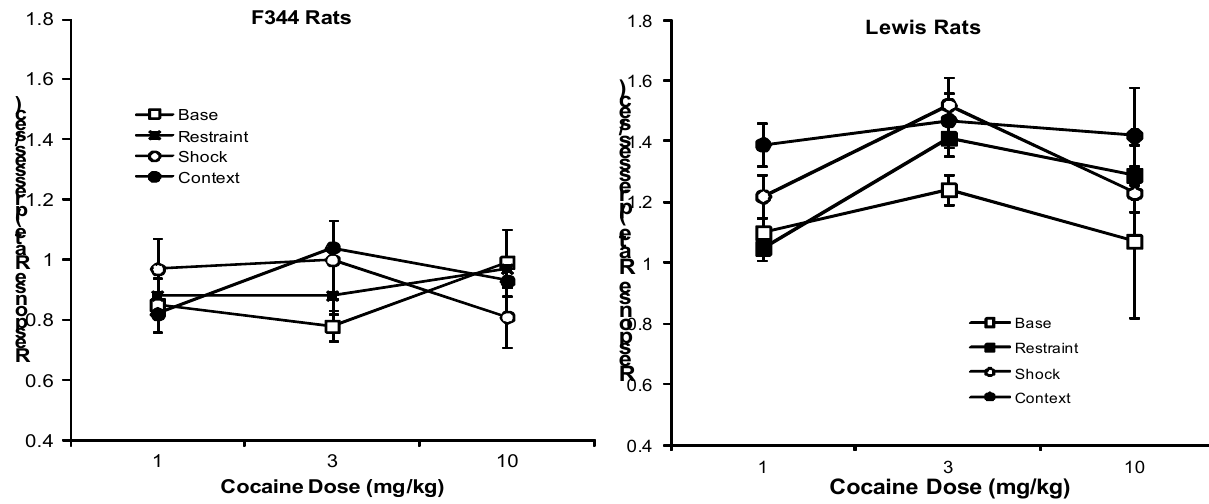
Figure 2. Mean (± S.E.M.) response rates (number of lever presses/sec) by cocaine dose (mg/kg) is shown for F344 (left panel) and Lewis (right panel) rats under baseline (open squares) conditions and following exposure to restraint (closed squares), footshock (open circles), and footshock-associated context (closed circles). Both footshock and its associated context increased response rates to cocaine in Lewis, but not in F344 rats. Restraint stress was without effect in both